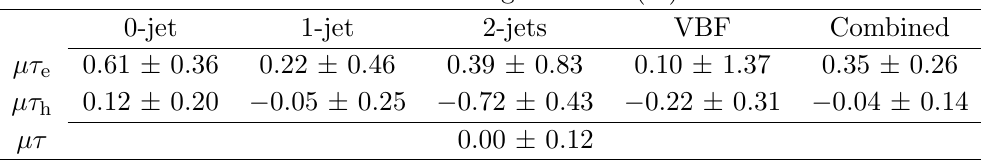
Table 4 . Expected and observed upper limits at 95% CL, and best (cid:12)t branching fractions in percent for each individual jet category, and combined, in the H ! (cid:22)(cid:28) process obtained with the BDT (cid:12)t